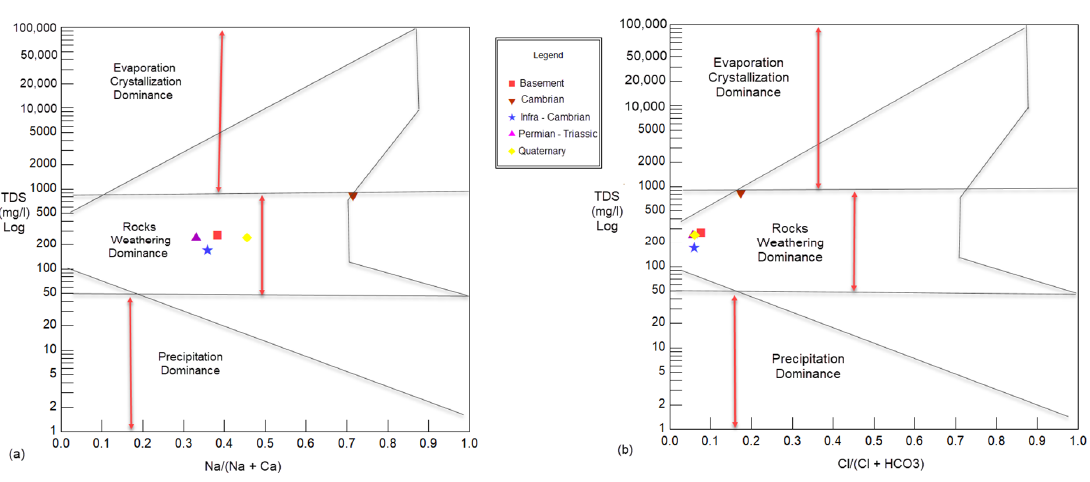
Figure 5. Mechanisms governing groundwater chemistry according to a Gibbs diagram: ( a ) TDS vs. Na + /(Na + + Ca 2+ ); ( b ) TDS vs. Cl − /(Cl − + HCO 3− ).